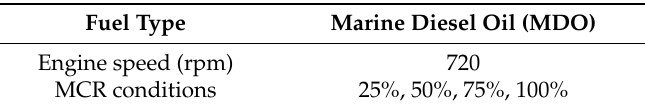
Table 4. Engine test